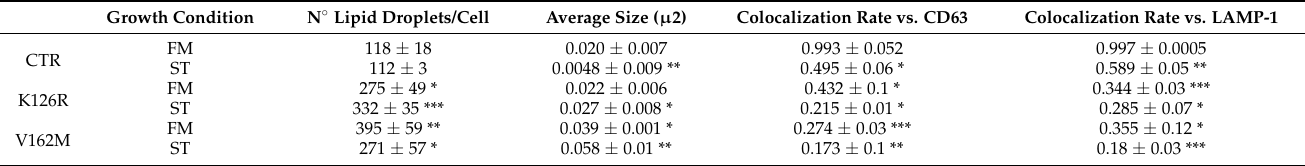
Table 1. Lipid Droplet Characteristics Determined as Determined by Microscopy.